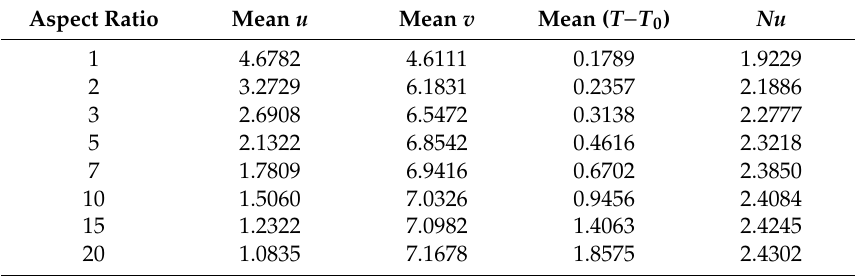
Table 2. Mean values of the velocity components, pressure, and temperature fields and Nu . Aspect